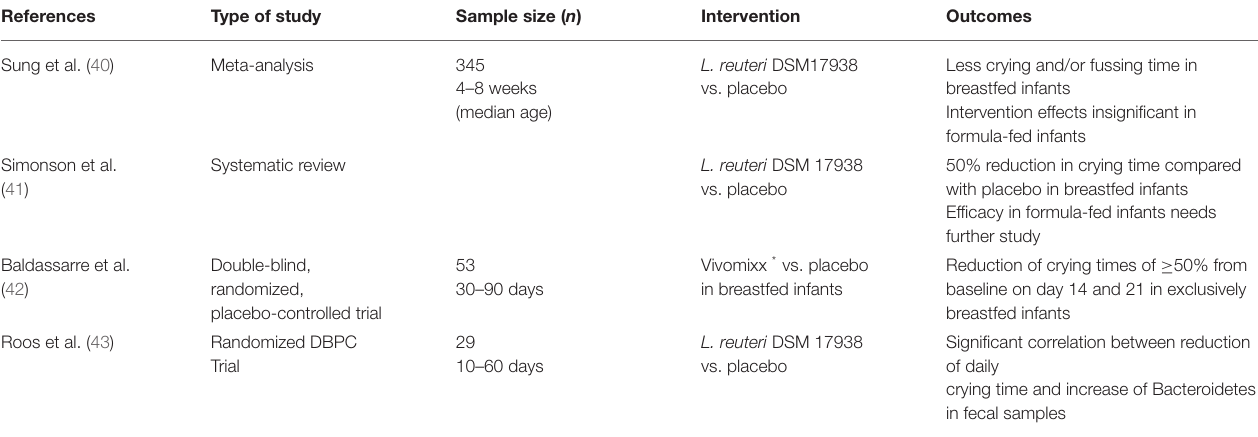
TABLE 1 | Infantile